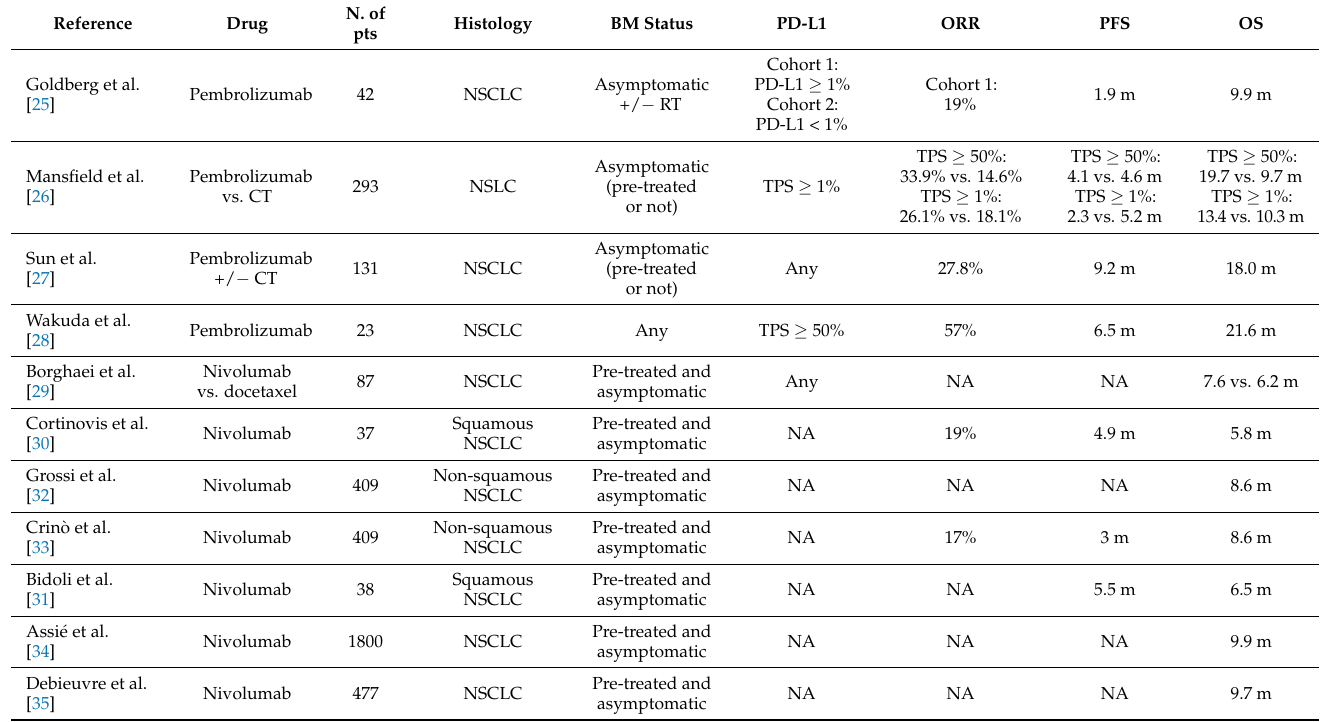
Table 1. Outcomes of patients with NSCLC and BM treated with single agent anti-PD-L1/PD-1 or anti-CTLA-4 monoclonal